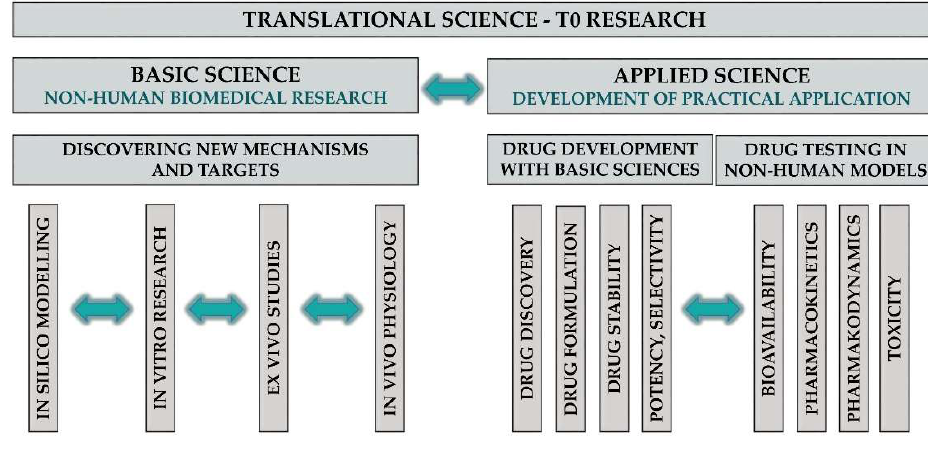
Figure 3. Translational science T0 research.